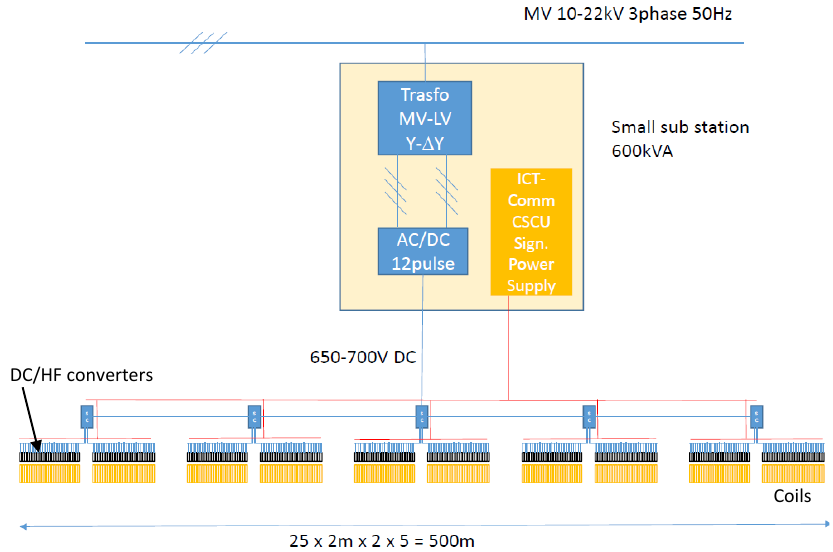
Figure 3. The adaptation of the POLITO solution for motorway applications.